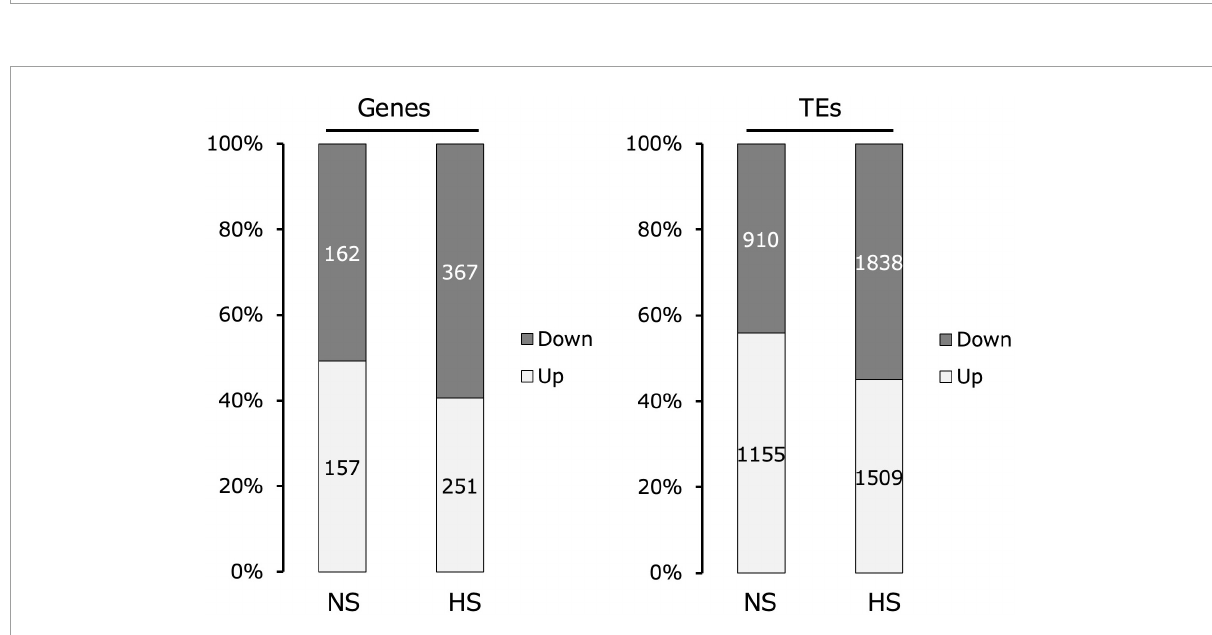
FIGURE2 Comparison of changes in gene and transposable element (TE) expression in the transcriptomes of Kyoto compared with those of Col-0 seedlings. Transcripts with more than two-fold change are